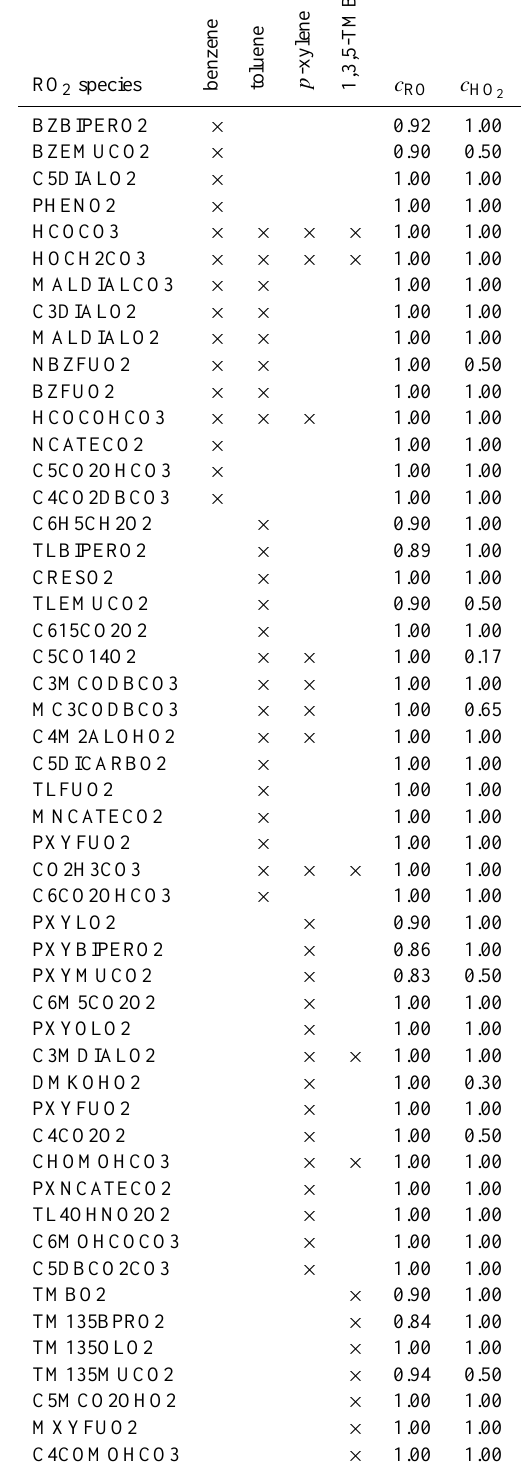
Table A1. Organic peroxy radicals (MCM specific designation) de- tectable but not discriminable by LIF and their respective RO yields ( c RO ) in RO 2 +NO reactions and subsequent HO 2 yields ( c HO RO+O 2 reactions as implemented in